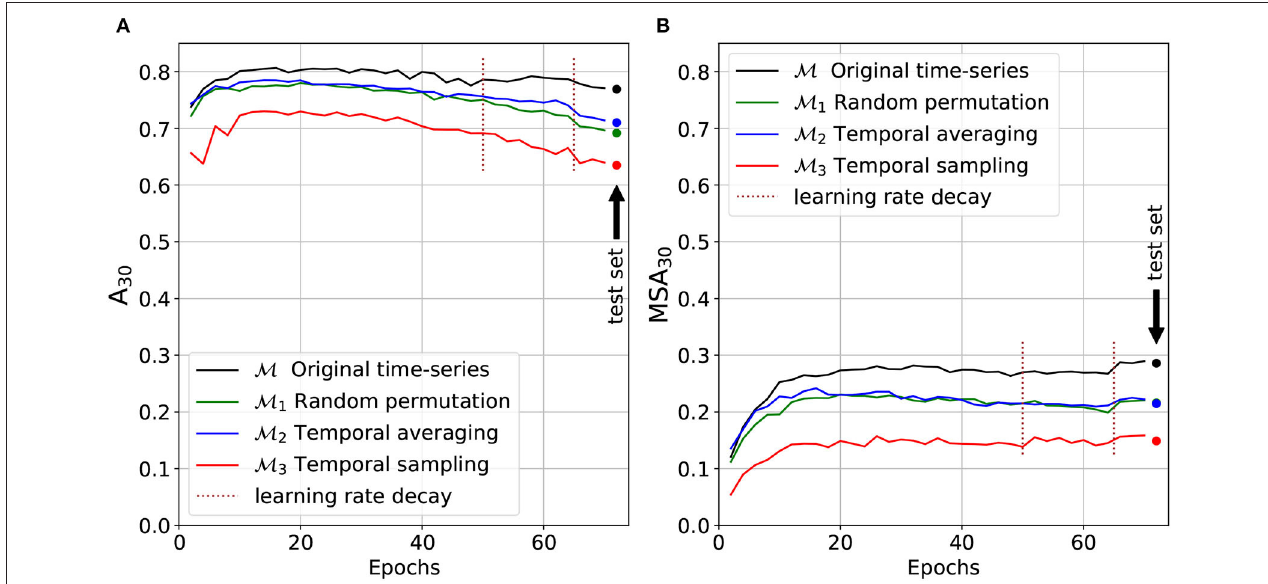
FIGURE 8 | Micro (A) and macro (B) average top-30 accuracy on models validation and test sets. Micro-average results tend to represent common species whereas macro-average performances are more representative of rare